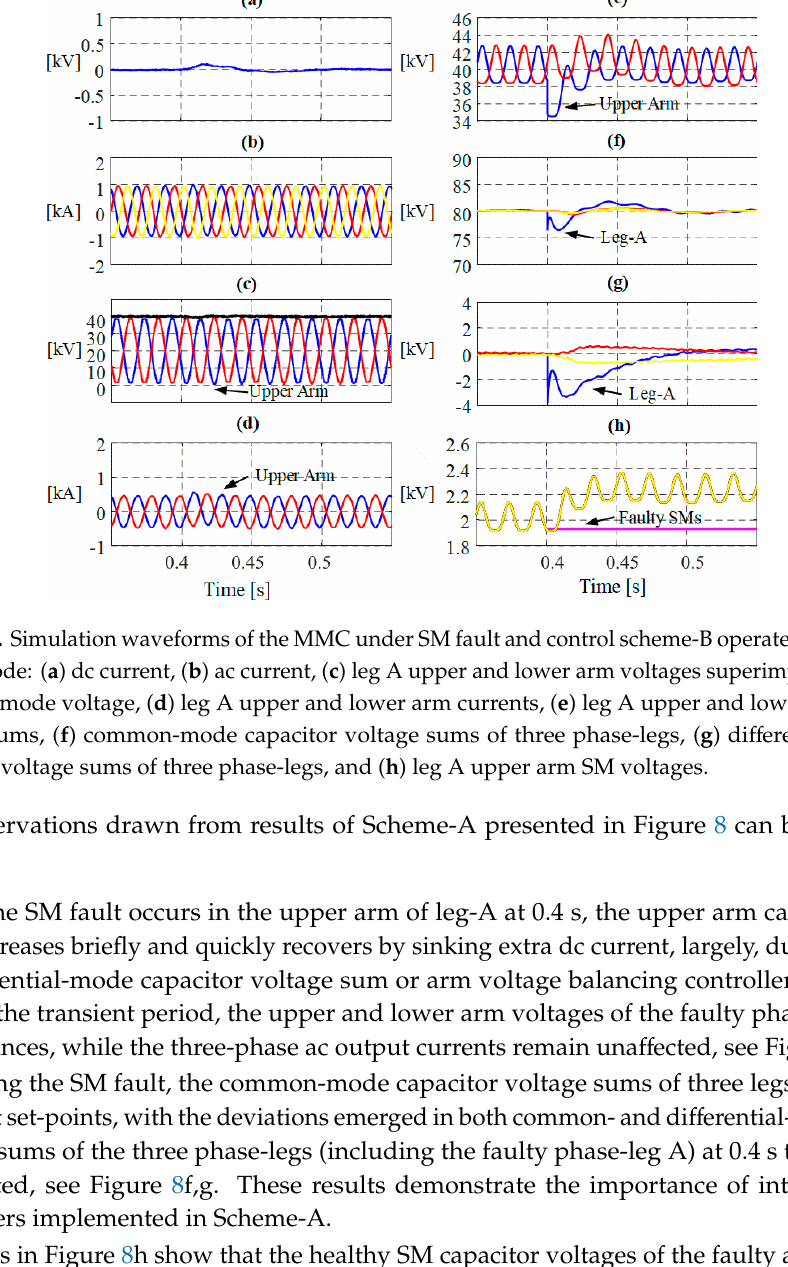
Figure 9. The observations drawn from the results in Figure 9 are as